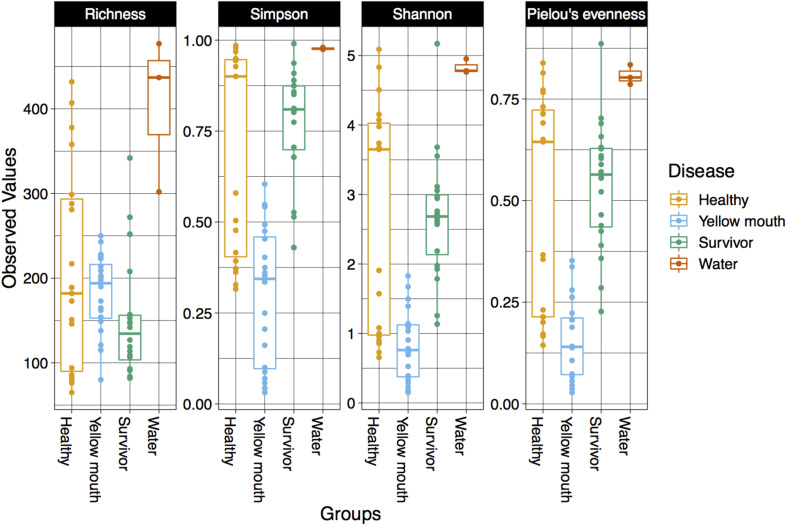
Diversity ofthe microbial community within different disease states and water samples. Boxplots show species richness, Simpsons, Shannon’s, and Pielou’s diversity indices.